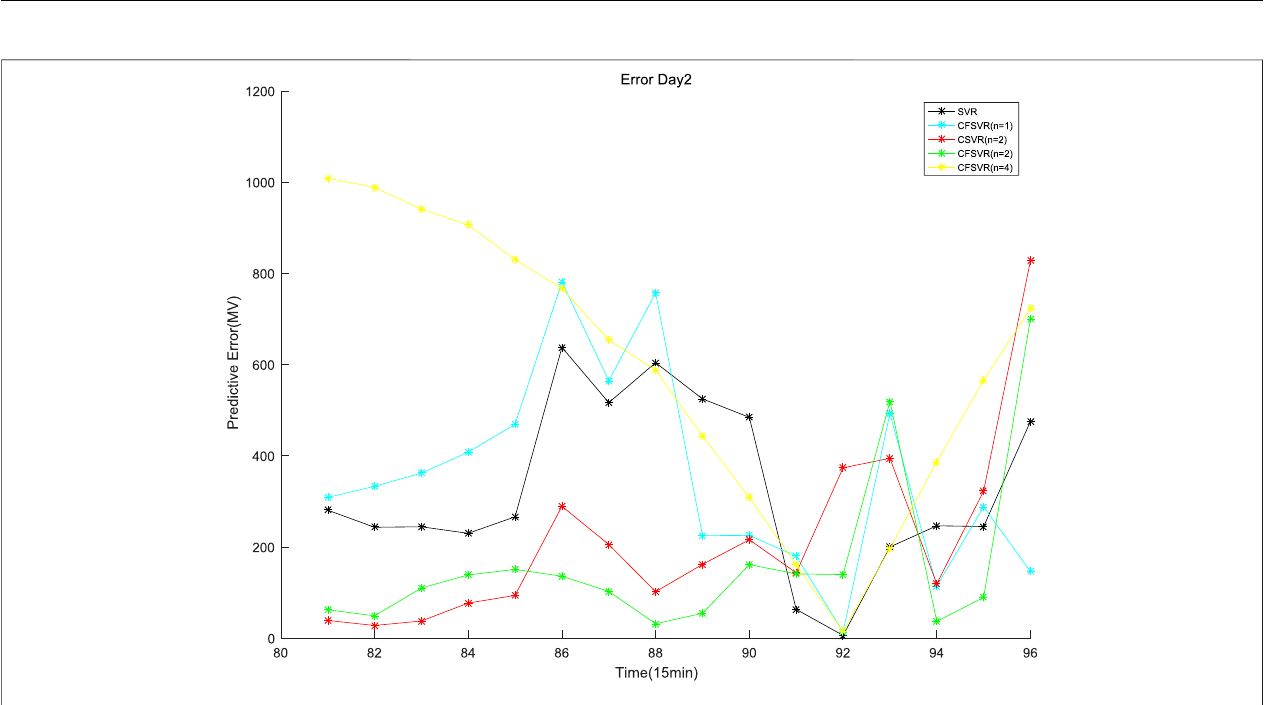
FIGURE 8 | Error of electric load forecasting of Day